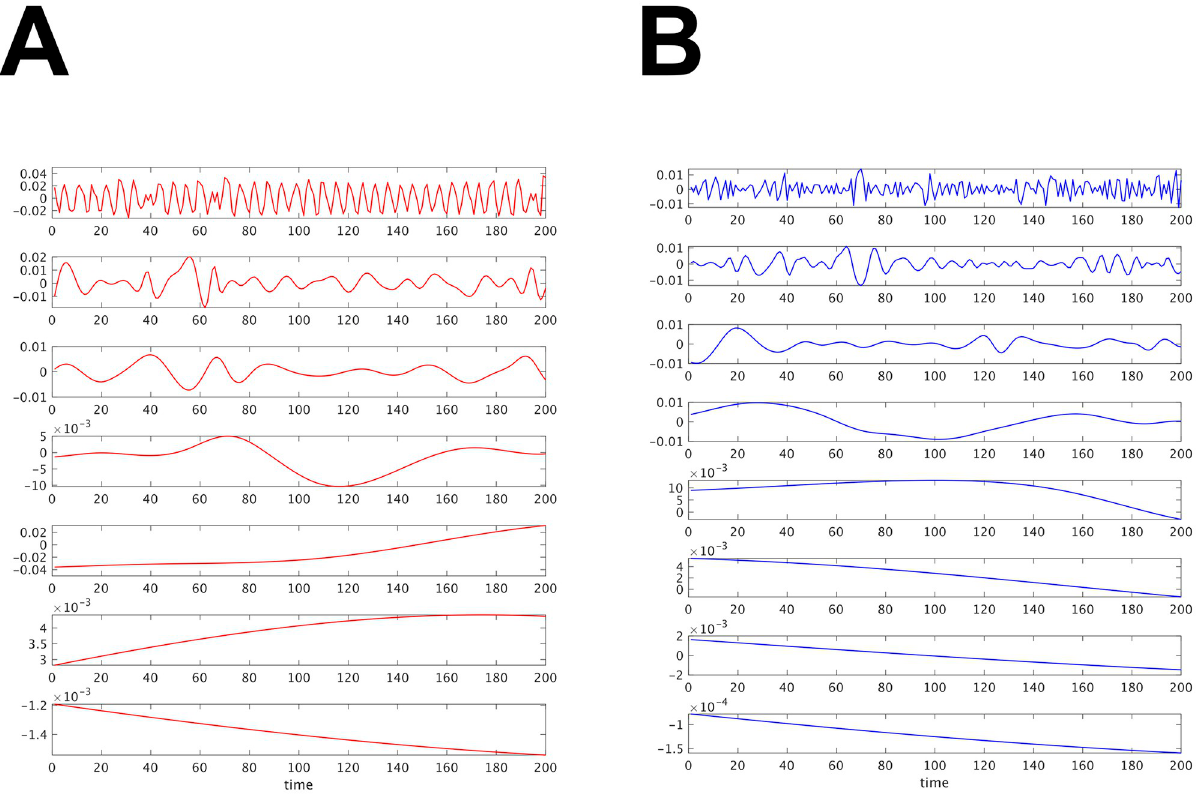
Fig 20. (A) Intrinsic mode functions in the oxy-Hb. (B) Intrinsic mode functions in the